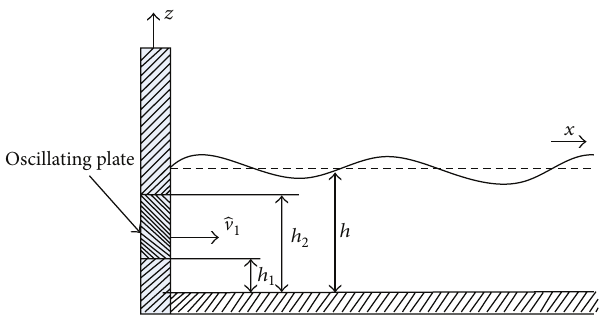
Figure 1: Cross section of the experimental